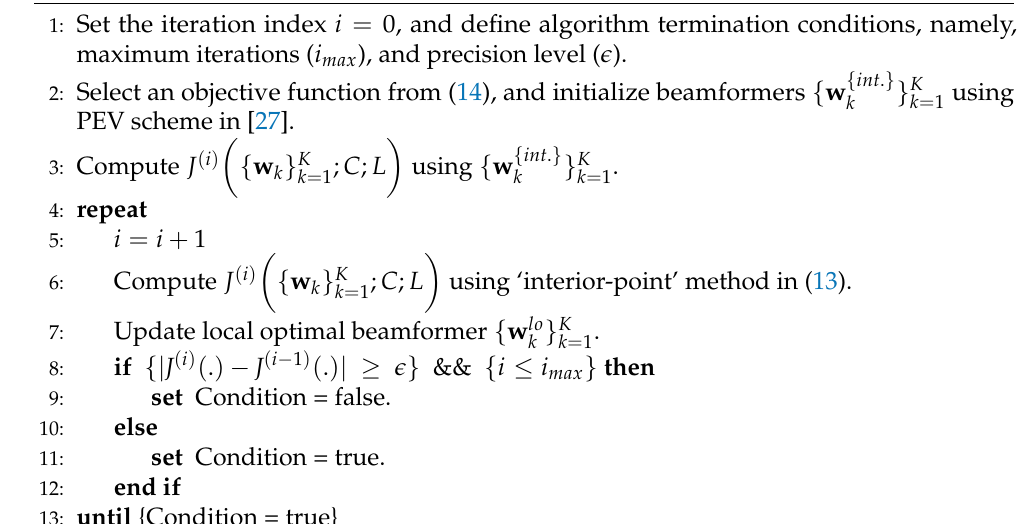
Algorithm 1 Construct of